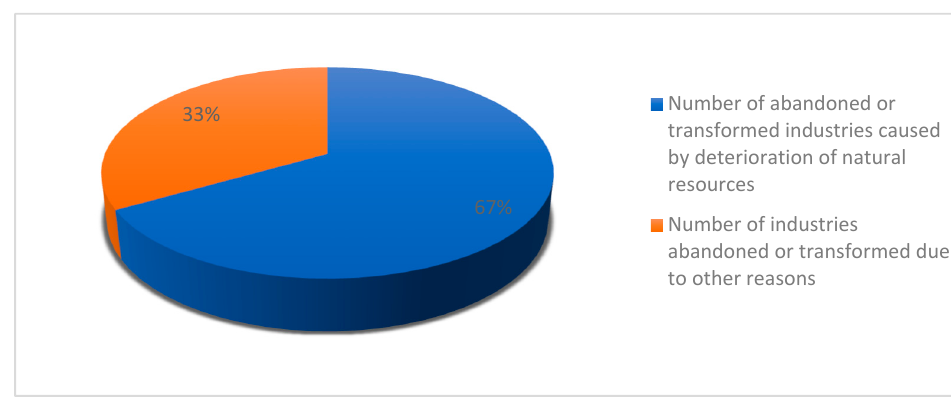
Figure 30. The relationship between the operation state of resource-intensive industries and natural resources deterioration (Figure source: own drawing; data source: on-site interviews).